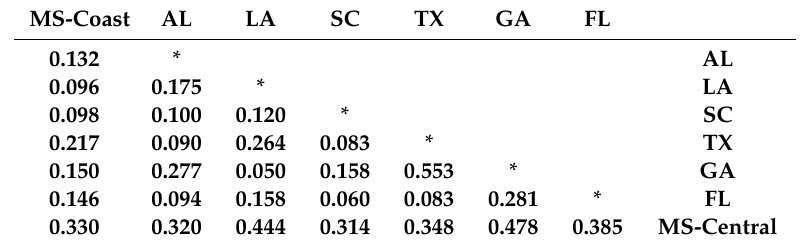
Table 2. Seven groups analyzed for population pairwise F ST1 , where MS-type (central) was separated from coast (AL-type) for the state-level analysis.